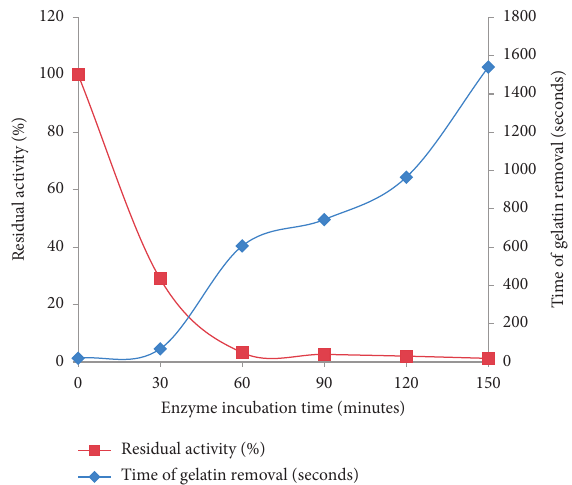
Figure 4: Stability of the enzyme at 70 ° C (reaction mix 40 ml or 288U).